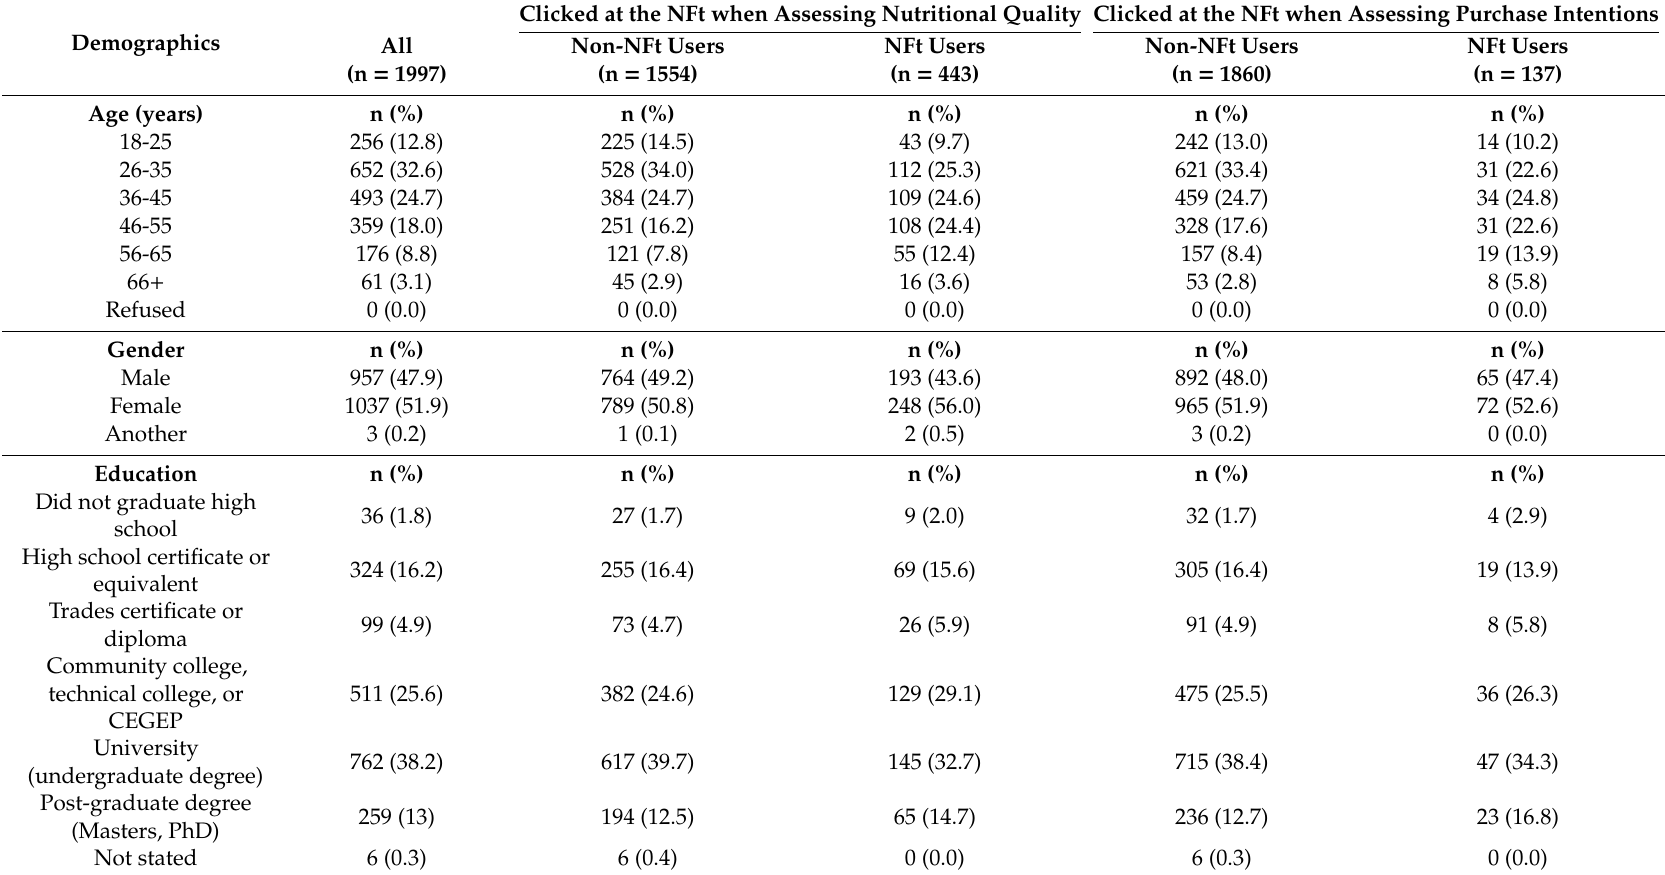
Table 1. Participants’ characteristics (n =